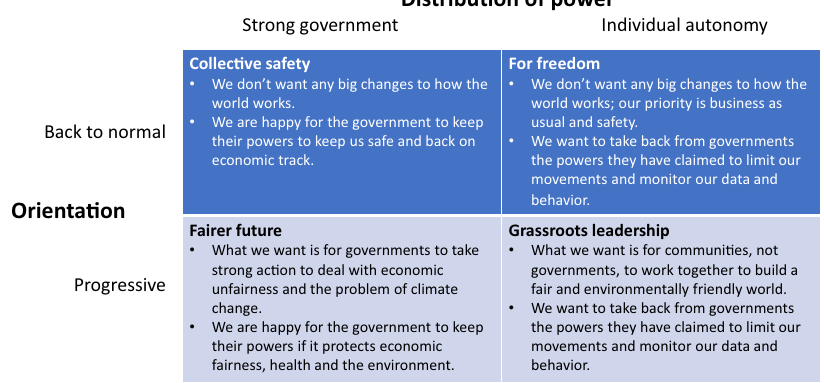
Fig. 1 Brief summary of the four scenarios used in the present experiments, grouped by the two dimensions (experimental variables) explored in the study. We designed each of these scenarios as having desirable aspects and being driven by good intentions, rather than juxtaposing scenarios that clearly differed with respect to intent and overall bene fi t. Any differences observed between scenarios should therefore re fl ect their deep structure instantiated by the experimental variables rather than emotional valence and overall attractiveness. Verbatim scenarios from both experiments are available in the